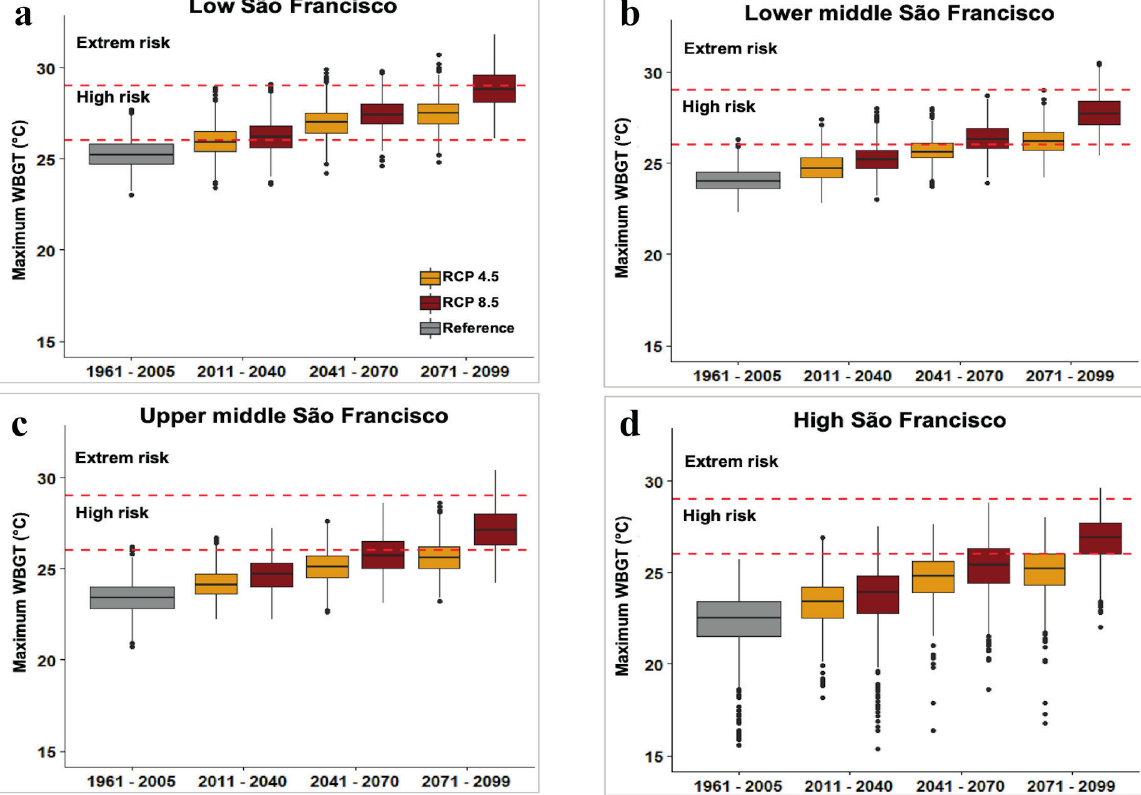
Figure 5 - the distribution of the daily values of the maximum WBGt for the warmest month of the reference period for the climate scenarios RCP 4.5 and 8.5 in the reference period (1961-2005) and the time windows 2011-2040, 2041-2071 and 2071- 2099, in ( a ) low, ( b ) lower Middle, ( c ) Upper Middle and ( d ) High San